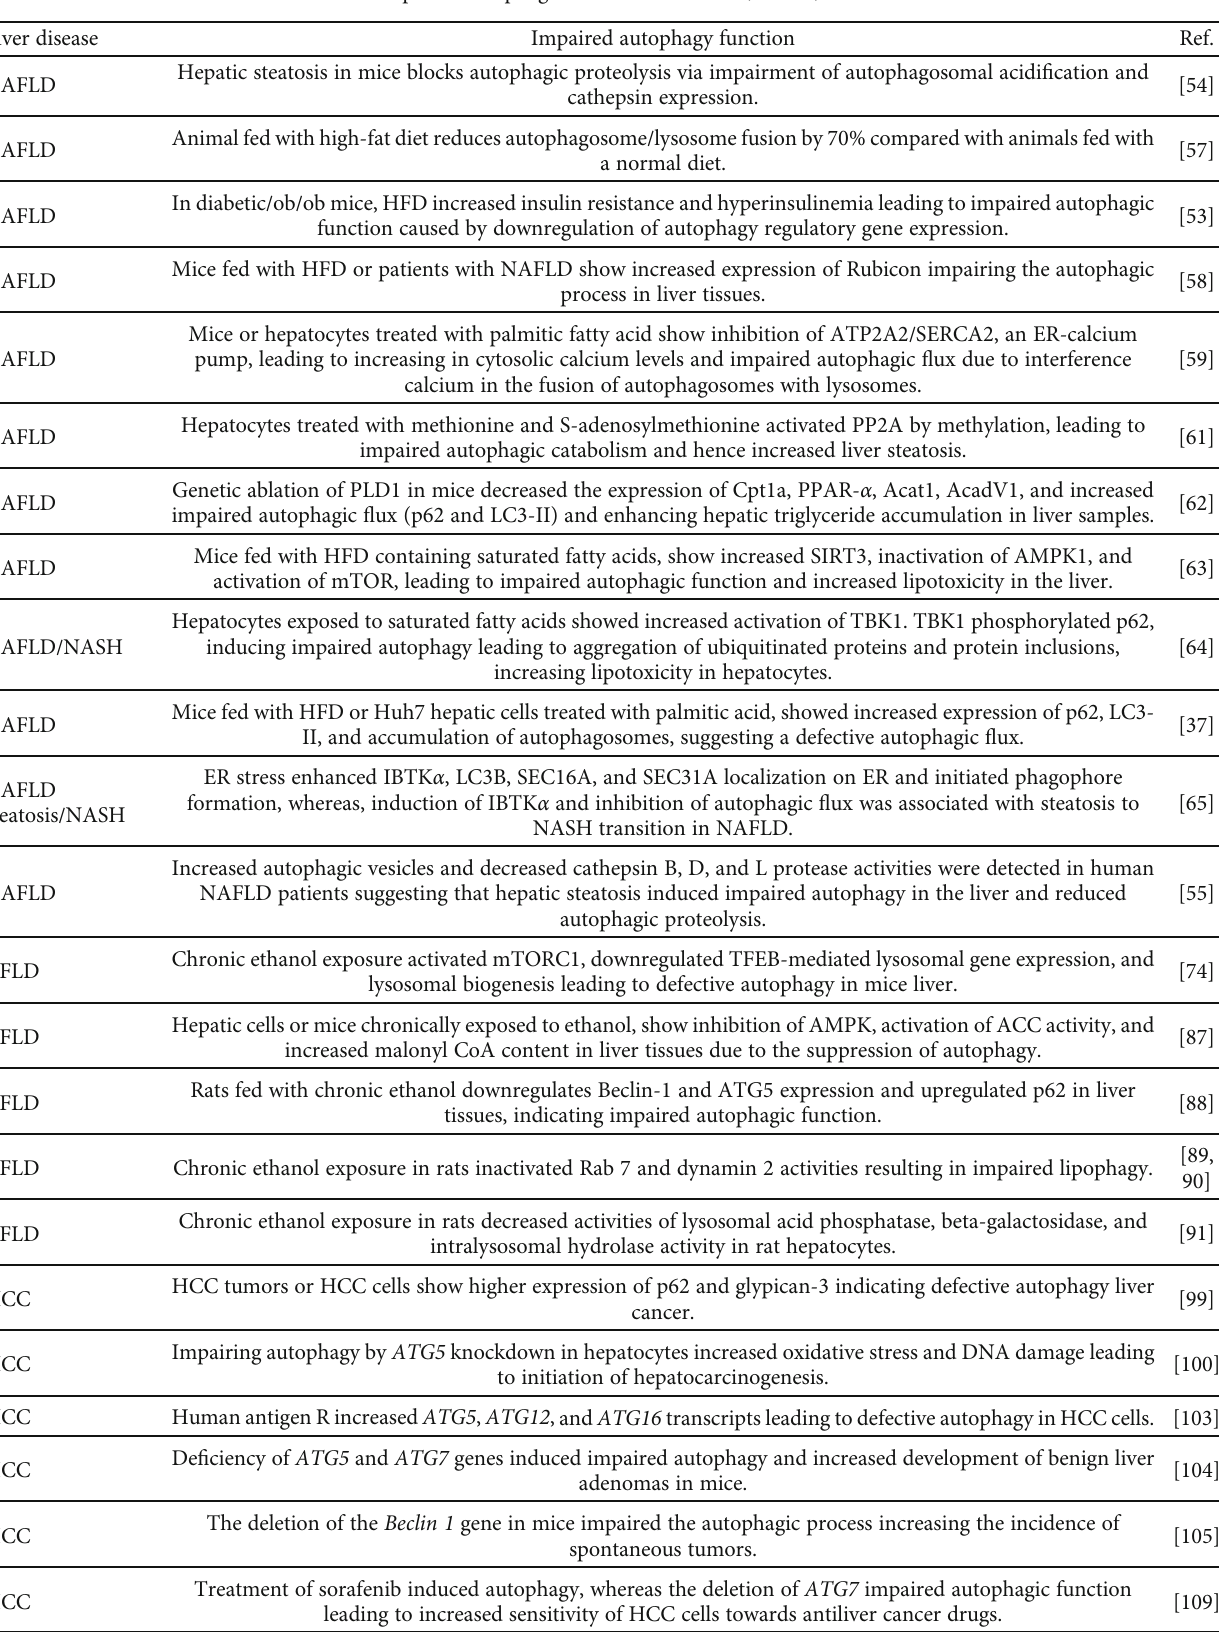
Table 1: Impaired autophagic function in NAFLD, AFLD, and